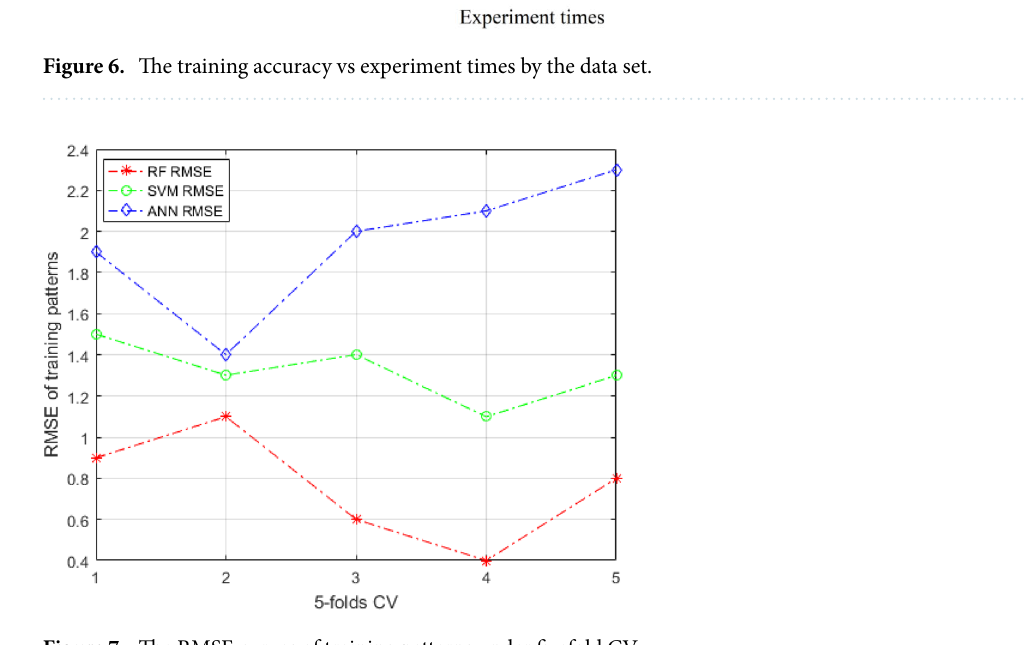
Figure 7. The RMSE curves of training patterns under fivefold